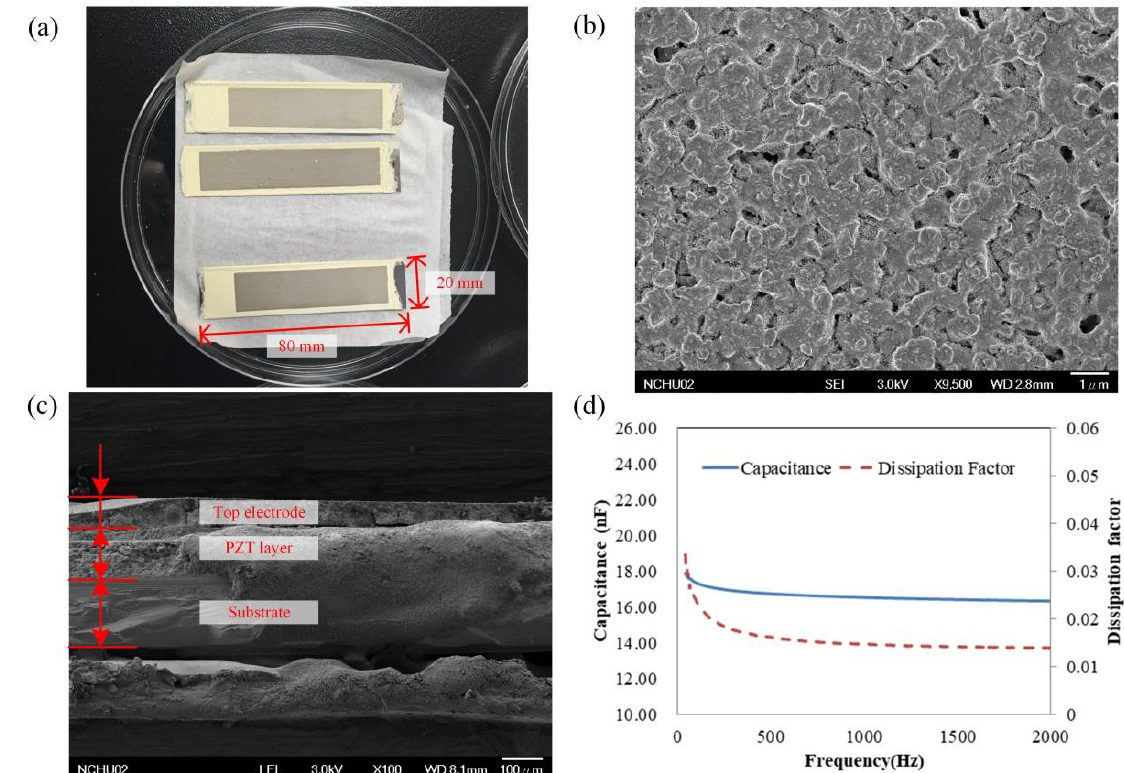
Figure 11. The result of the piezoelectric composite film. ( a ) The piezoelectric composite beam; ( b ) The morphology of the PZT film; ( c ) The SEM image of the cross-section; ( d ) the Capacitance test.